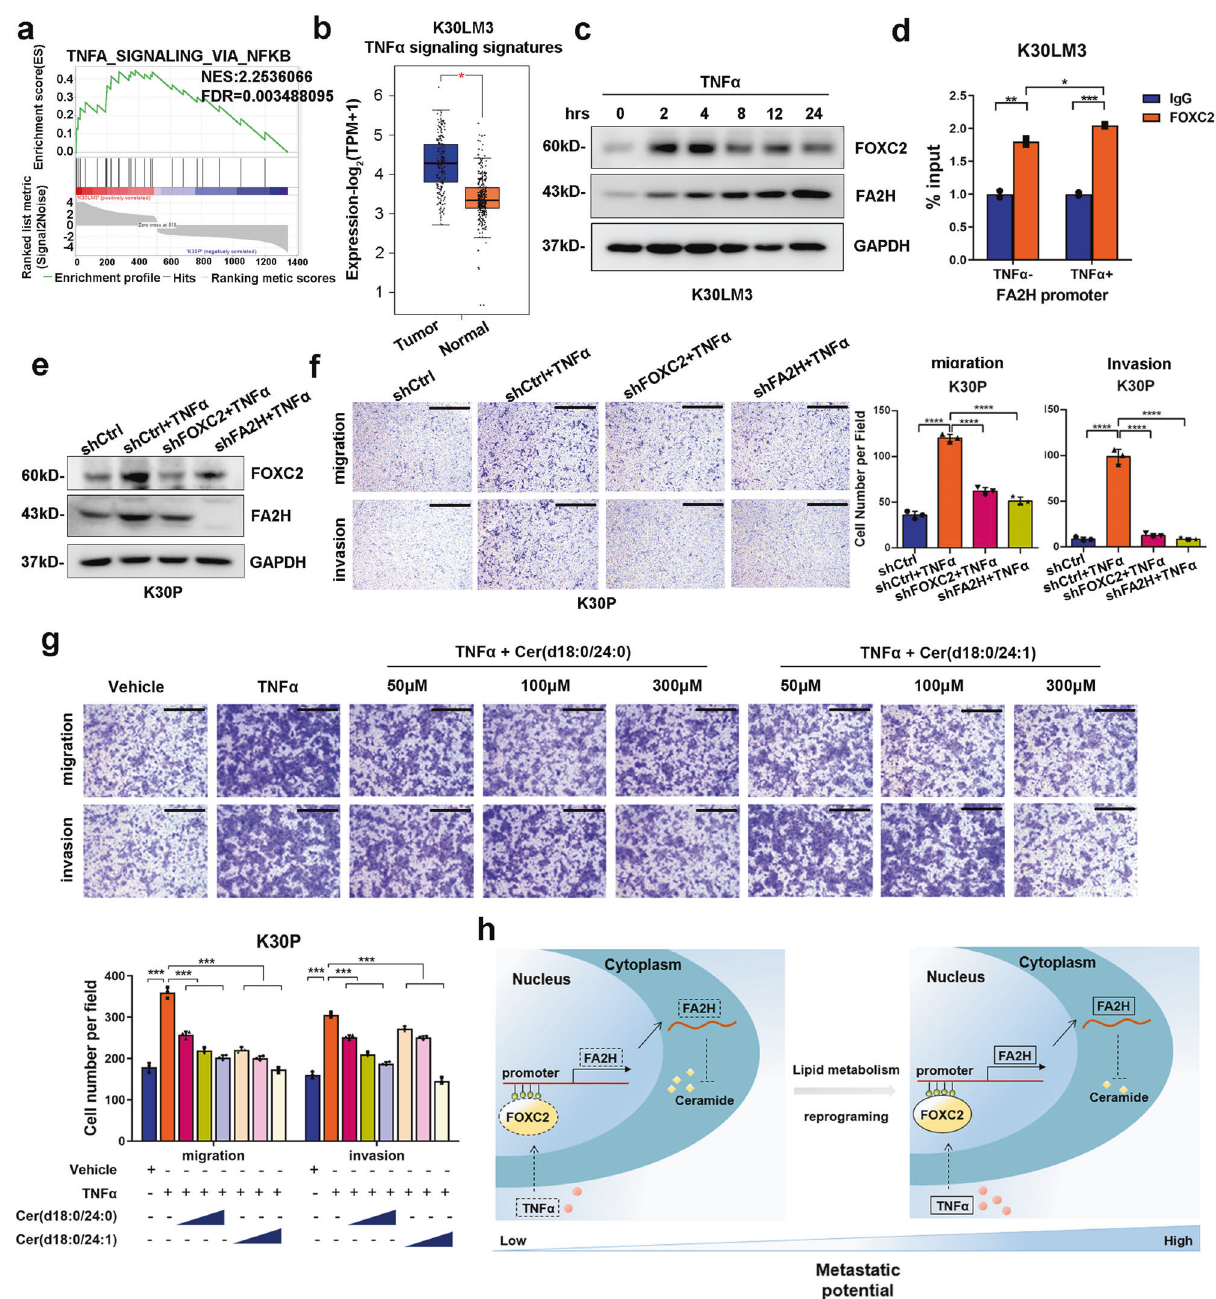
Fig. 6 TNF α promotes metastasis by activating FOXC2-FA2H axis. a Geneset enrichment analysis shows ‘ TNF α signaling via NF- κ B ’ gene signature were signi fi cantly enriched in K30LM3 relative to K30P cells. Each of the black bars represents a gene in the pathway. b Analysis of TNF α signaling gene signature identi fi ed from K30LM3 cells in TCGA ESCA dataset using GEPIA2 tool. c Western blotting analysis of FOXC2 and FA2H protein level after TNF α treatment at different time points in K30LM3 cells. d ChIP analysis of FOXC2 occupancy on the promoters of FA2H upon TNF α treatment. e Western blotting analysis of TNF α -induced FOXC2 and FA2H protein level in K30P expressing shRNA targeting FOXC2, FA2H or a control hairpin (shCtrl). f Transwell assay analysis of TNF α -induced FOXC2 and FA2H expression on migration and invasion ability in K30P cells expressing shRNA targeting FOXC2, FA2H or a control hairpin (shCtrl). Scale bar, 500 µm. g Representative images of K30P transwell assay with TNF α treatment alone or in combination with Cer(d18:0/24:0) or Cer(d18:0/24:1) in a serial concentration. Scale bar, 500 µm. h Proposed working model for TNF α -activated FOXC2-FA2H axis governed ceramide metabolic reprogramming in ESCC. Error bars denote mean ± SD. * P < 0.05, ** P < 0.01, *** P < 0.001, **** P < 0.0001 These G418-resistant tumor cells were denoted as the fi rst generation Beige mice. For the fi rst round selection, lung metastatic lesions were of lung metastatic derivatives (LM1). Similarly, LM1 cells were observed after 3 months for both cells. Mice were then sacri fi ced, and subjected to another round of in vivo selection by injecting them metastatic nodules were dissected and dissociated into pieces, and into the SCID/Beige mice, which gave rise to lung metastatic nodes grown in the culture dishes. G418 were used to select and and the second generation of lung metastatic derivatives (LM2). differentiate tumor cells from fi broblast and other stromal cells.